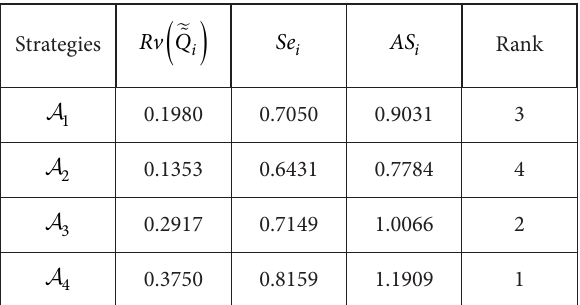
Table 9. The final scores for evaluation of strategies Strategies